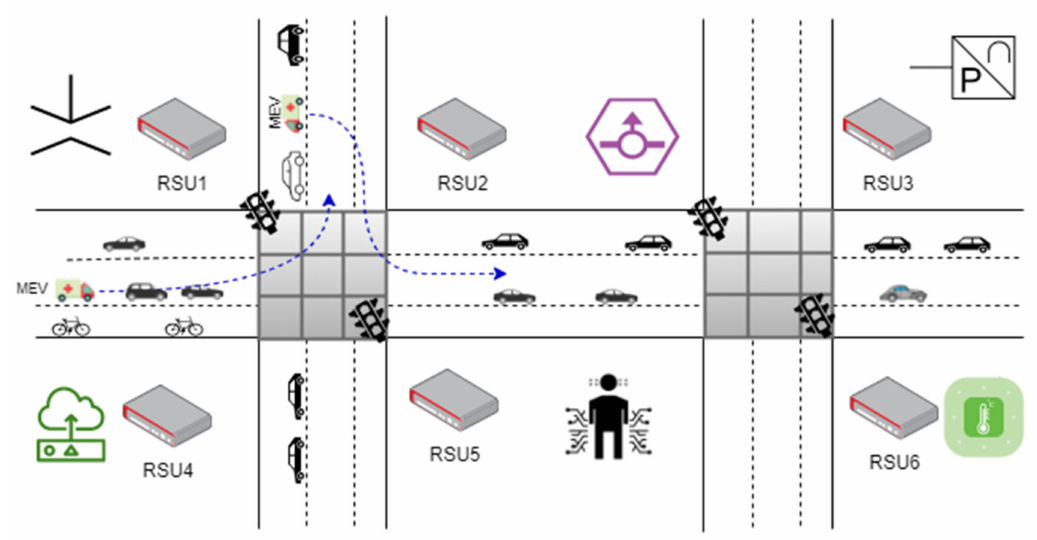
Figure 3. Case 1, mentioned in Algorithm 1 (when both vehicles have the same priorities). Figure 4 models the situation in which two EVs, FEV and MEV on junction K1, and PEV and FEV on junction K2, are coming from varying directions and cannot cross simulta- neously. In such a situation, the decision will be taken based on the process mentioned in Algorithm 2. The detailed working of both algorithms is also shown in the flow chart of Figure 5, where VAT refers to vehicle arrival